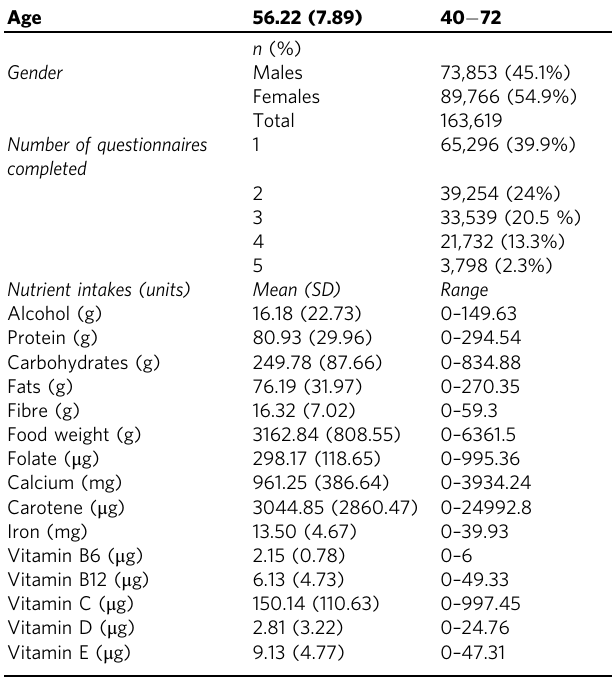
Table 1 Descriptive statistics: age, sex, number of questionnaires completed, and nutrient intakes in 163,619 participants of the UK Biobank